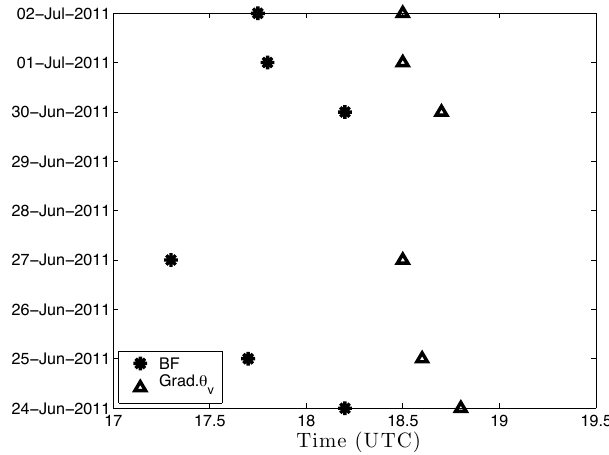
Figure 4. For each IOP, instant when buoyancy flux (bullets) and virtual potential temperature gradient (triangles) change